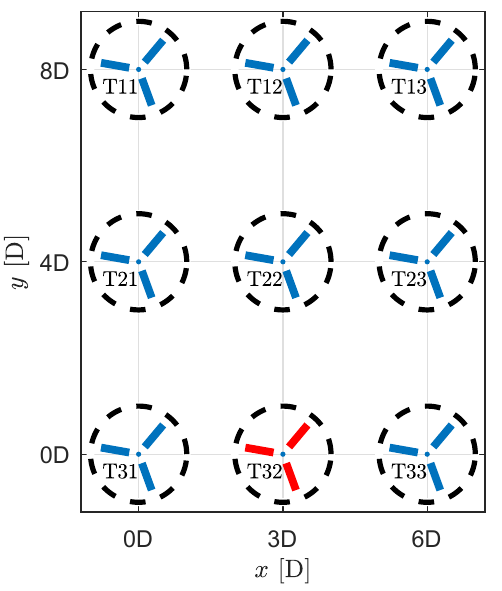
Figure 4. Layout of the reference wind farm. The reference turbine (T32) is marked in red.